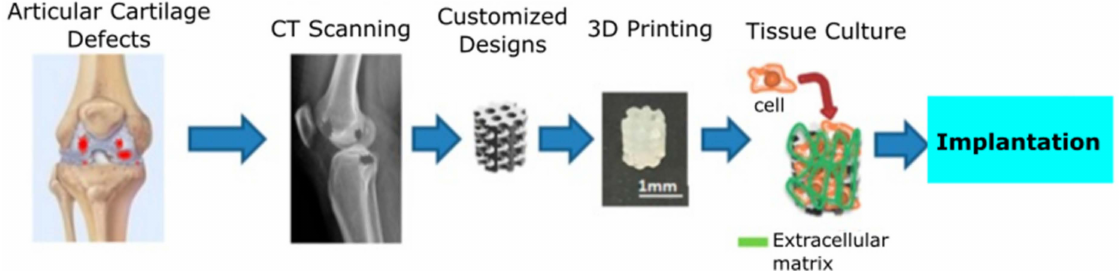
Figure 14. Schematic representation shows the 3D Printing of Water-Based Light-Cured Polyurethane with Hyaluronic Acid scaffolds for Cartilage Tissue Engineering Applications (Reproduced with permission from [114] CC-BY license,